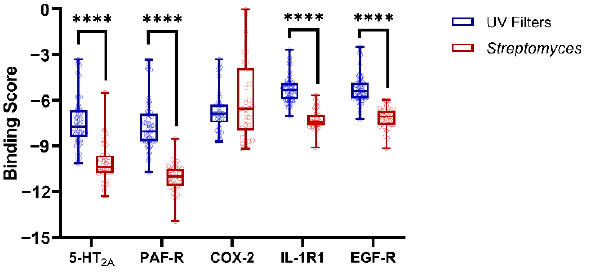
Figure 8. Comparison between the binding scores showed by UV filters and Streptomyces -derived compounds with the best binding scores. Binding scores of AUVFs were calculated using the docking protocol described before. The distribution of the docking results for both groups is shown by a box and whiskers graph. The nonparametric Mann–Whitney U test was used to evaluate the significant difference between the groups (i.e., AUVFs vs. Streptomyces -derived compounds) for each target; **** p -value < 0.0001.